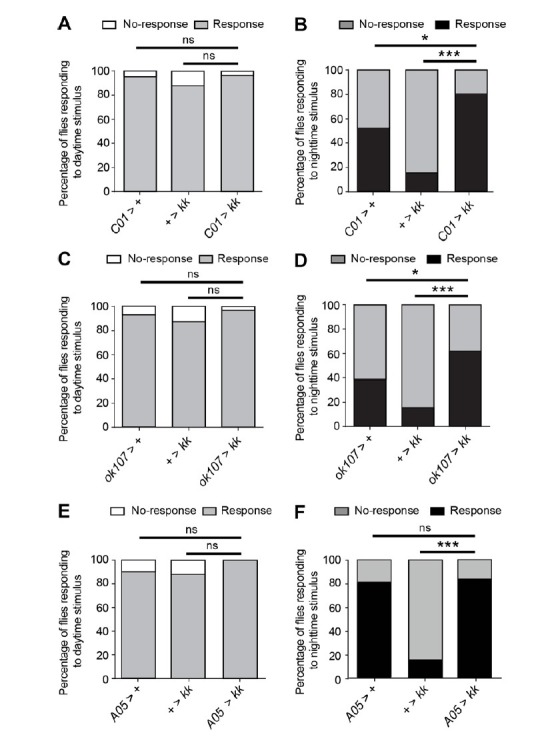
NCA acts in the mushroom bodies to regulate nocturnal arousal.(A-B) Percentage of adult male flies expressing Nca RNAi (kk) in C01-neurons (C01 > kk) and control flies responding or not responding to vibration stimulus at either ZT4 (day; A) or ZT16 (night; B). ZT4: C01 > +, n = 22, + > kk, n = 61, C01 > kk, n = 27. ZT16: C01 > +, n = 19, + > kk, n = 54, C01 > kk, n = 21. (C-D) Percentage of adult male flies expressing Nca RNAi (kk) in MB-KCs (ok107 > kk) and control flies responding or not responding to vibration stimulus at either ZT4 (day; C) or ZT16 (night; D). ZT4: ok107 > +, n = 26, + > kk, n = 47, ok107 > kk, n = 28. ZT16: ok107 > +, n = 26, + > kk, n = 44, ok107 > kk, n = 27. (D-E) Percentage of adult male flies expressing Nca RNAi (kk) in A05-neurons (A05 > kk) and control flies responding or not responding to vibration stimulus at either ZT4 (day; A) or ZT16 (night; B). ZT4: A05 > +, n = 19, + > kk, n = 61, A05 > kk, n = 29. ZT16: A05 > +, n = 20, + > kk, n = 54, A05 > kk, n = 31.ns – p > 0.05, *p < 0.05, ***p < 0.001, Binomial test with Bonferonni correction for multiple comparisons.